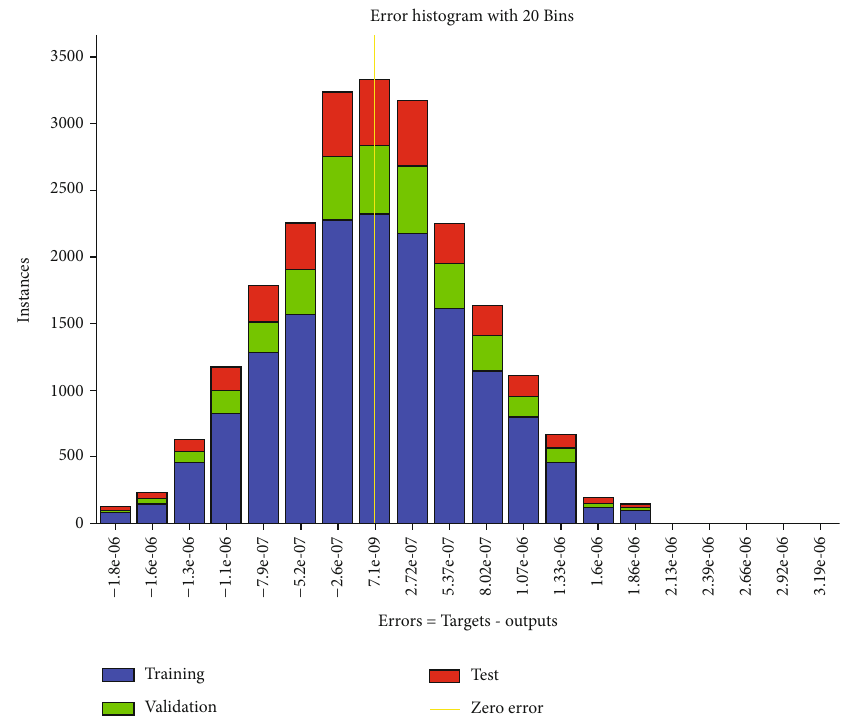
Figure 6: DNN-PV MPPT controller error histogram.